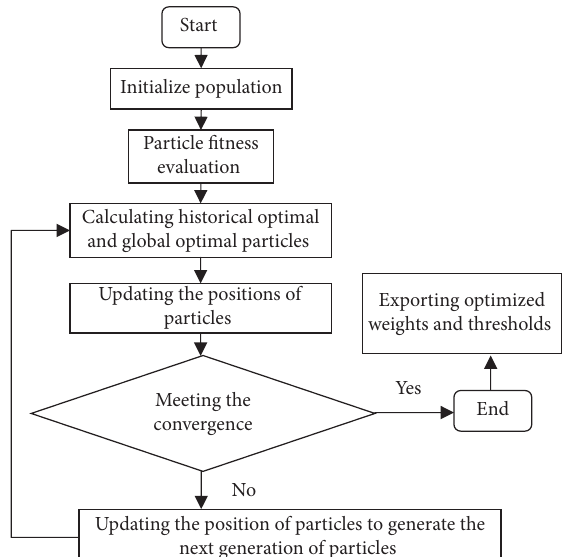
Figure 2: The flowchart of the prediction model based on the